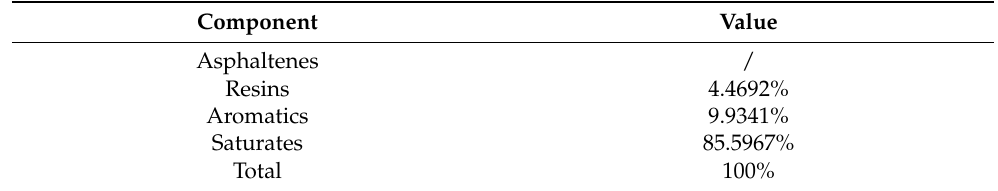
Table 3. Results of SARA analysis of 0# diesel oil.